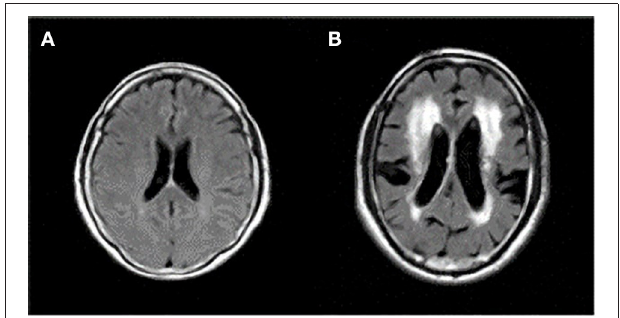
FIGURE 1 | Axial magnetic resonance imaging (MRI) sections of two different brain features of healthy elderly individuals, both 70 years of age, who can drive normally. (A) Minimum of brain atrophy (BA) and leukoaraiosis (LA). (B) Larger BA with enlarged ventricles and sulci, and larger LA around